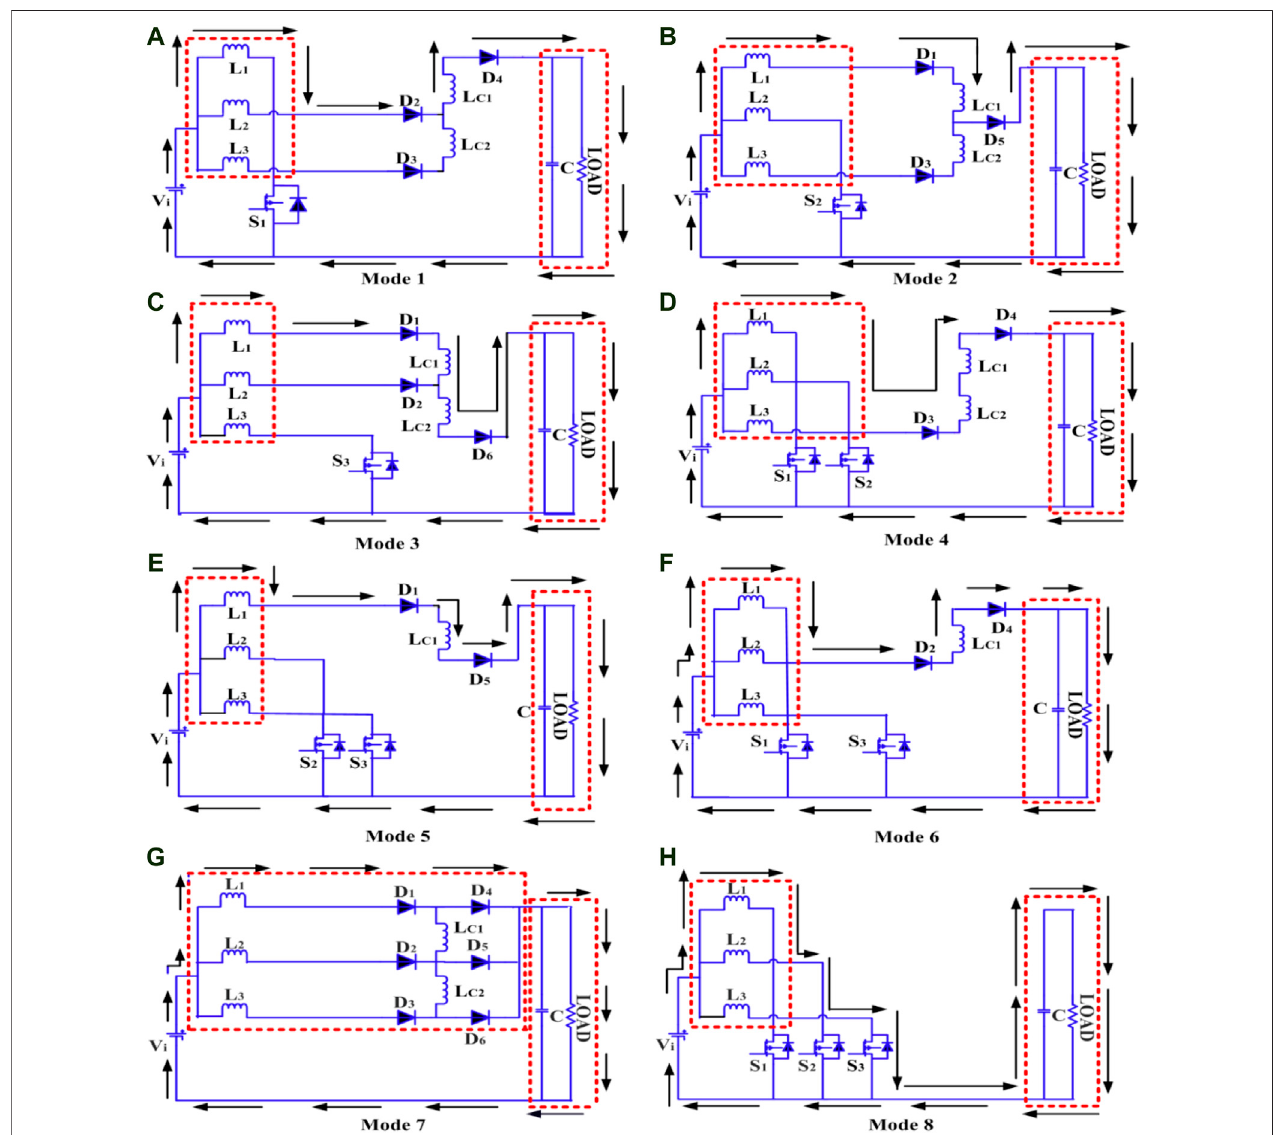
FIGURE 3 | Modes of